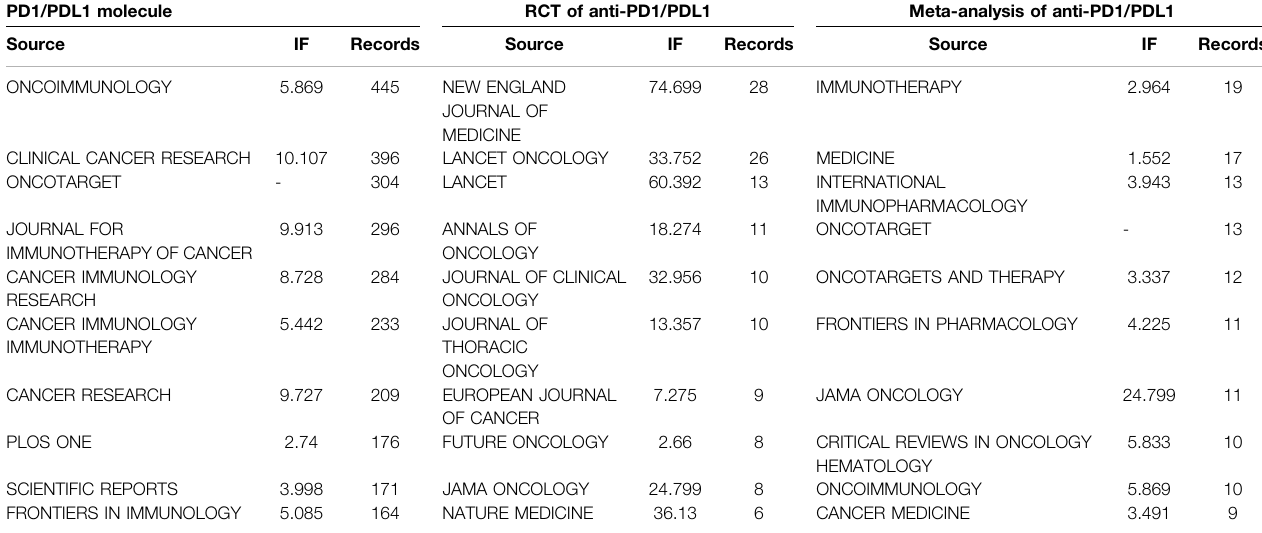
TABLE 3 | Top 10 contributors in terms of journal among the three datasets.